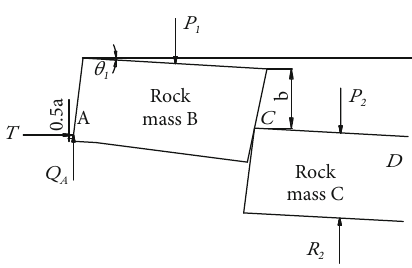
Figure 5: “ Sidestepped rock beam ” load